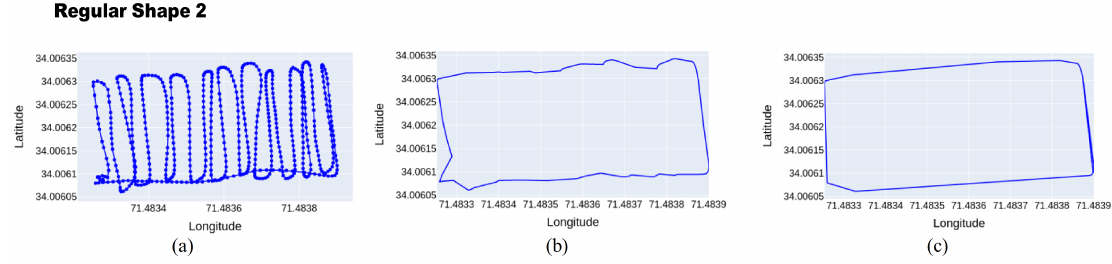
Figure 3. Comparison of boundary detection algorithms ( a ) Actual GPS Plots, ( b ) concave hull using KNN and ( c ) convex hull using Delaunay